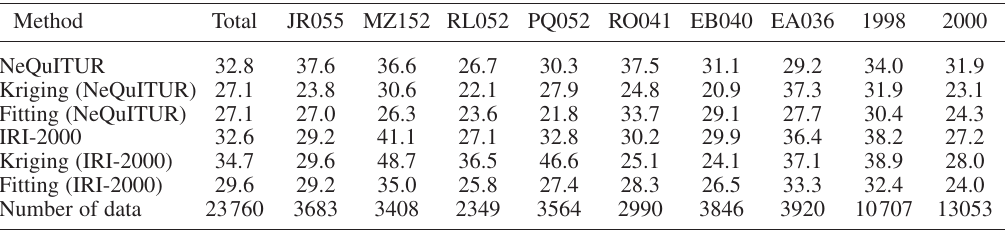
Table 3.II. Results of IRI-2000 and NeQuITUR height profile adaptation, broken down by station and year. Against each prediction method is shown the average percentage deviation for the specified station or period.